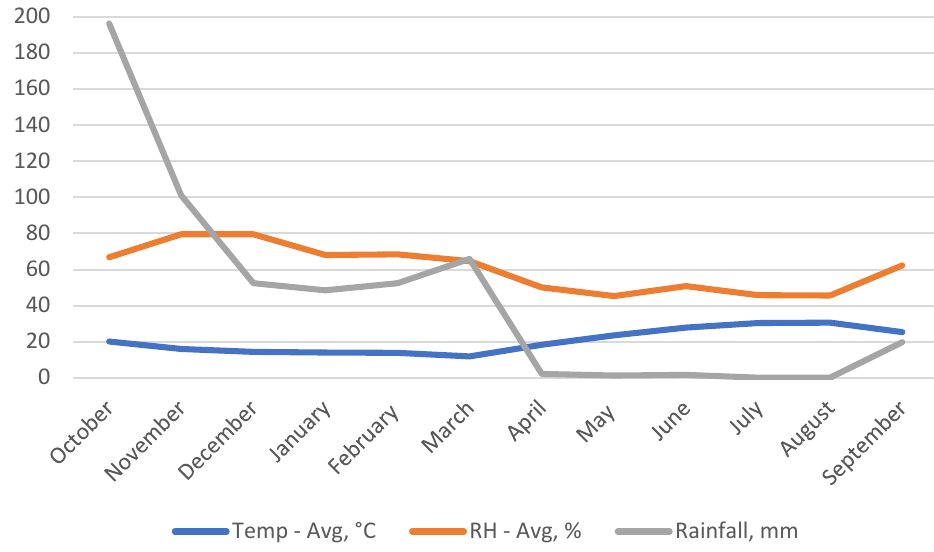
Figure 1. Climatic trend of the experimental area during the year of investigation.